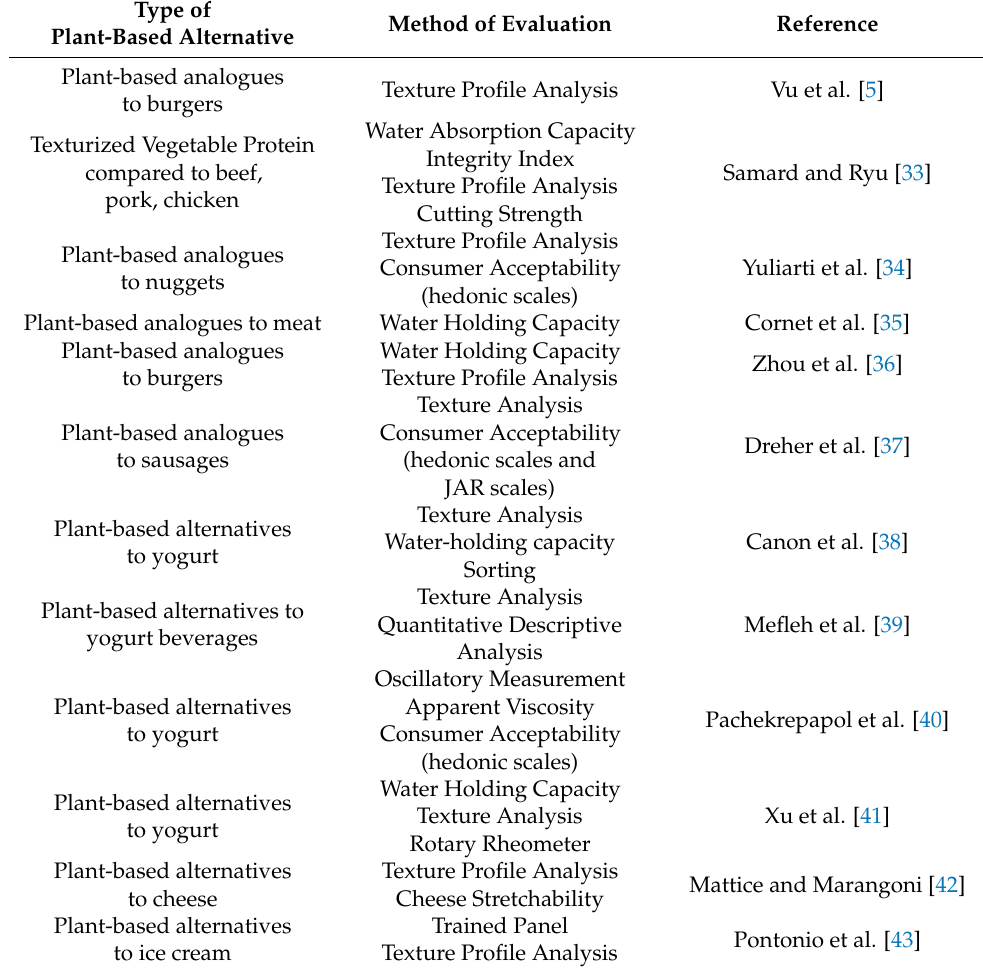
Table 1. Examples of the different studies investigating the textural properties of plant-based